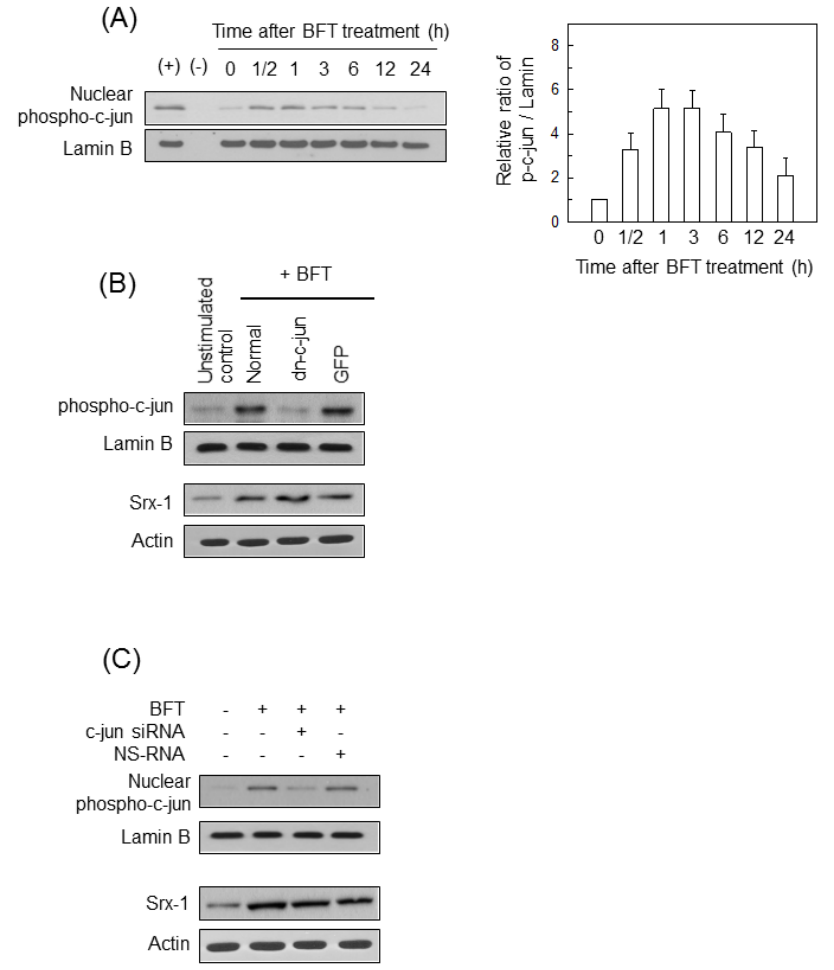
Figure 3. Effects of AP-1-inhibition on Srx-1 expression in BFT-exposed HCT 116 cells. ( A ) BFT (300 ng / mL) was added to HCT 116 cells for the indicated periods of time. Nuclear protein expression of phospho-c-jun and lamin B was examined by western blot. Positive controls ( + ) were obtained from cells that were treated with 20 µ M of TNF- α for 1 h. Right panel shows densitometric analysis for expressed proteins. Values represent the relative densities of each protein compared with lamin B (mean ± SD, n = 3); ( B ) HCT 116 cells were transfected with either lentivirus containing a dominant-negative c-jun plasmid (dn-c-jun) or control virus (GFP). BFT (300 ng / mL) was added to each group for 1 h (phospho-c-jun) or 18 h (Srx-1). Nuclear protein expression of phospho-c-jun and lamin B was examined by western blot. Concurrently, protein expression of Srx-1 and actin was also evaluated by western blot; ( C ) HCT 116 cells were transfected with siRNA against c-jun or NS-RNA. BFT (300 ng / mL) was added to each group for 1 h (phospho-c-jun, top panels) or 18 h (Srx-1, bottom panels). Analysis of protein expression was identical to ( B ). All images in ( A – C ) are representative of more than three independent